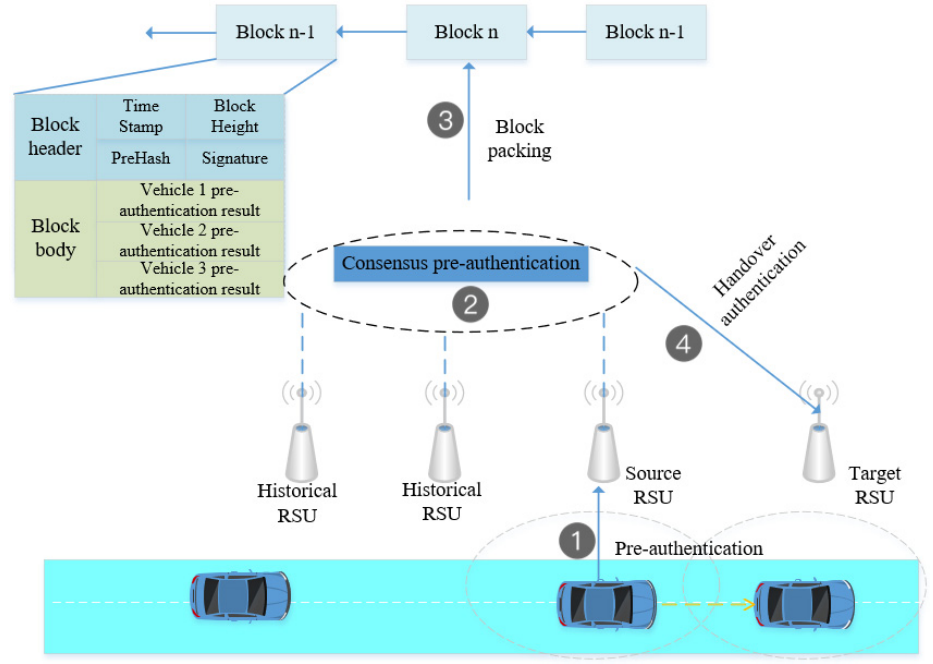
Figure 2. Process overview of vehicle pre-authentication and handover authentication.